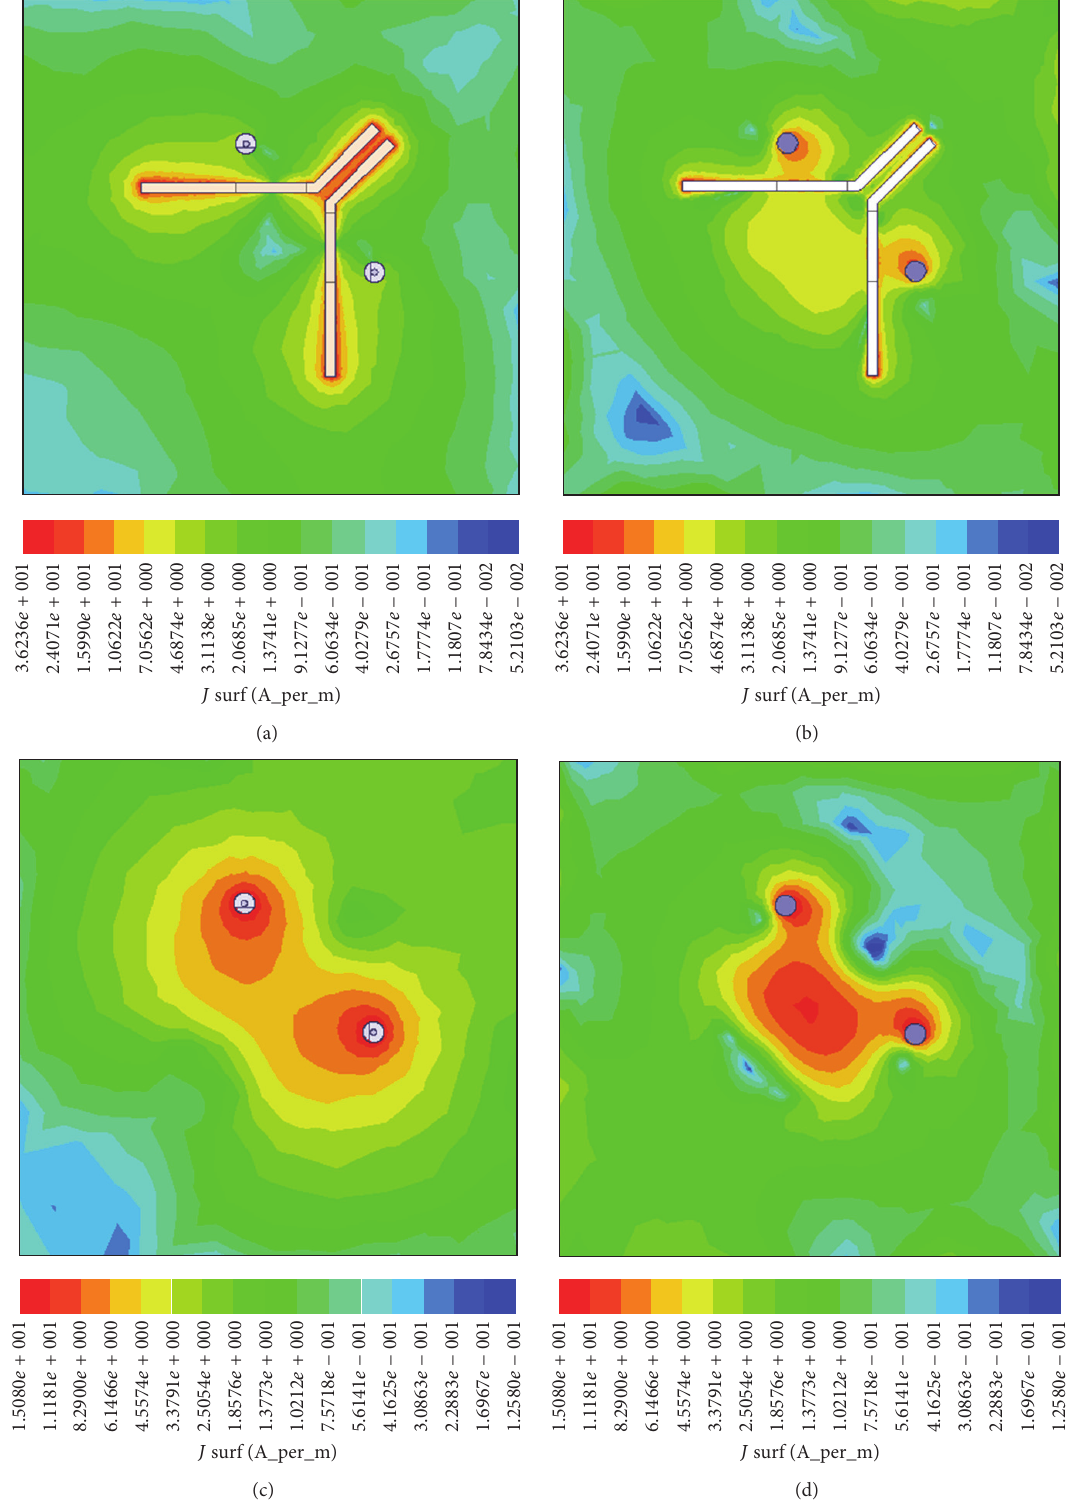
Figure 8: Current distribution plots (a) with slots at 1.47 GHz, (b) with slots at 2.4 GHz, (c) without slots at 1.47 GHz, and (d) without slots at 2.4